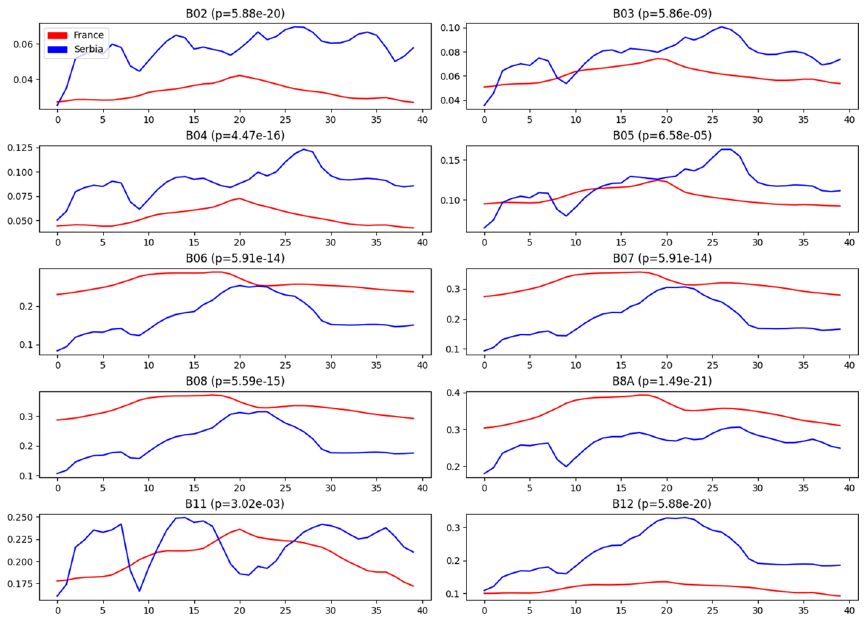
Fig. 3 Averaged reflectances of each band for two training datasets, with p values of Kolmogorov–Smirnov